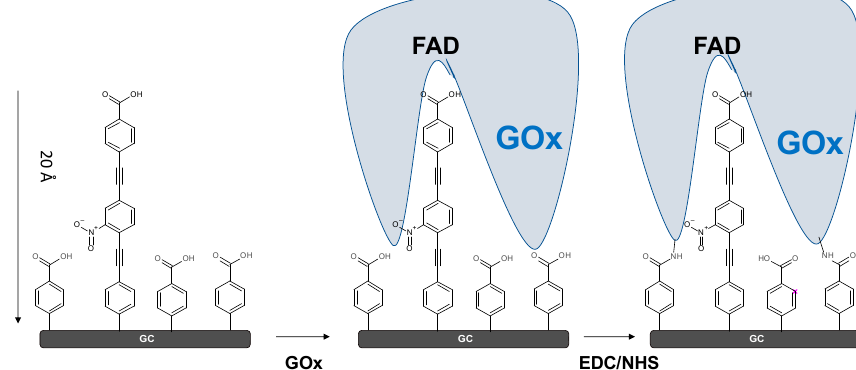
Figure 13. Biosensor of glucose based on the direct electron transfer to the of GOx flavine adenine dinucleotide (FAD) co-enzyme through a molecular wire.